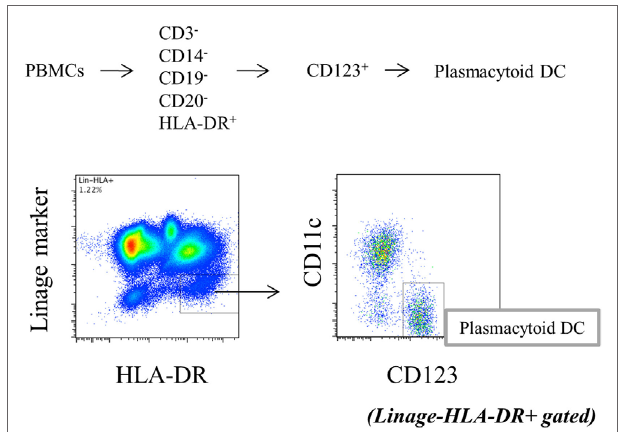
FigUre 1 | Gating strategy of plasmacytoid dendritic cells (Lin − HLA − DR + CD11c − CD123 +